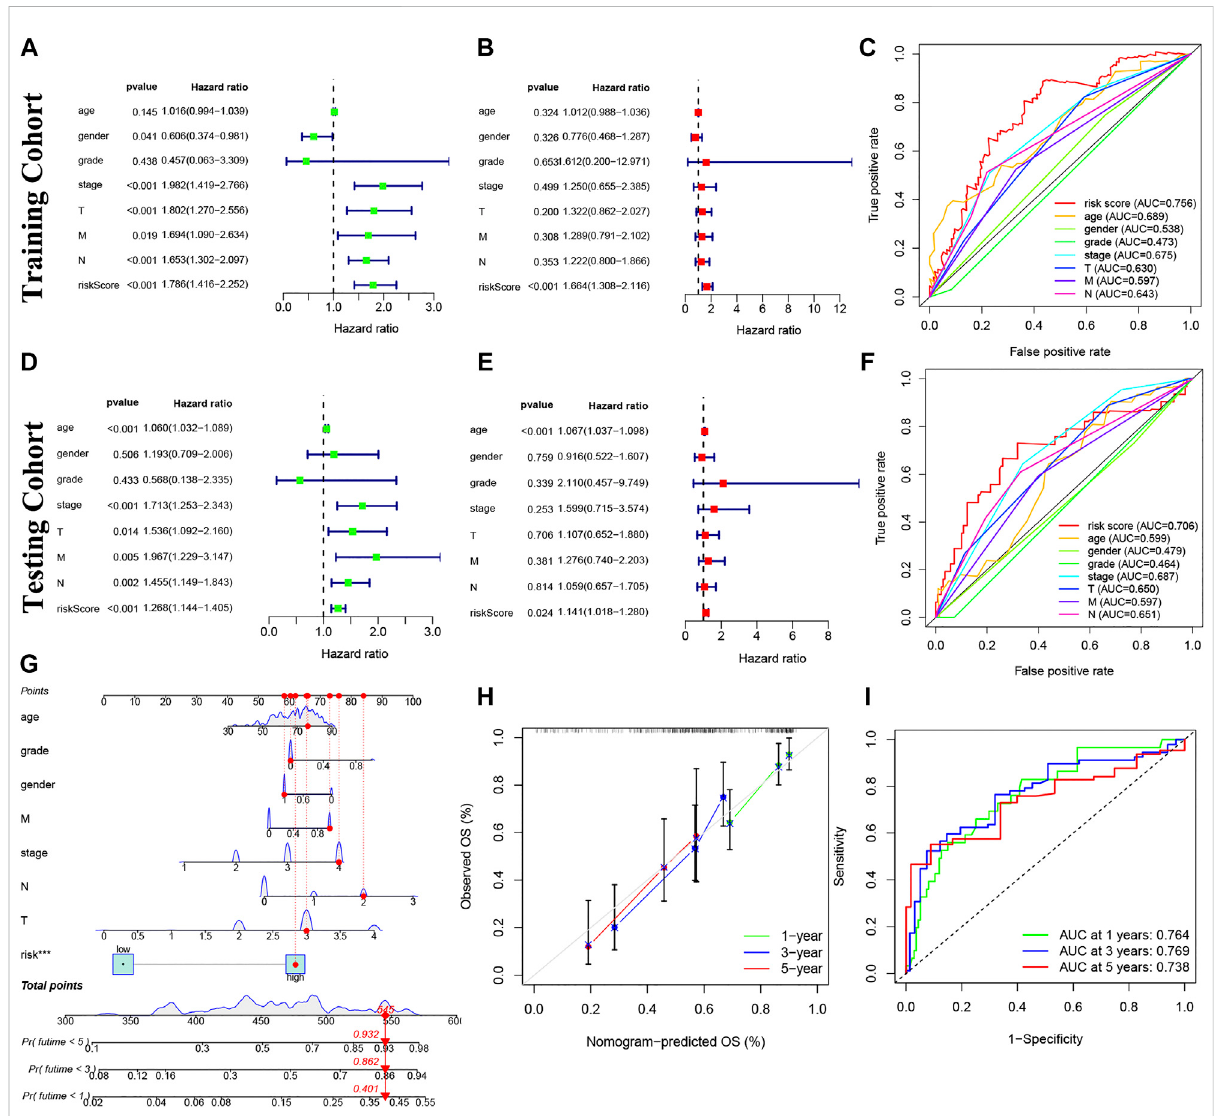
FIGURE 6 Prognosis value of model lncRNAs in BC. (A,D) : Univariate analysis. (B,E) : Multivariate analysis. Panel (C,F) : The ROC curves (Training cohort: AUC = 0.756; Testing cohort: AUC = 0.706). (G) Nomogram of 1-, 3- and 5-years survival. (H) Calibration curve. (I) The results of ROC curves in predicting of BC survival rates at 1-, 3- and 5- years (1-year-AUC = 0.764, 3-years-AUC = 0.769, 5-years-AUC = 0.738). ROC, receiver operator characteristic; AUC, area under